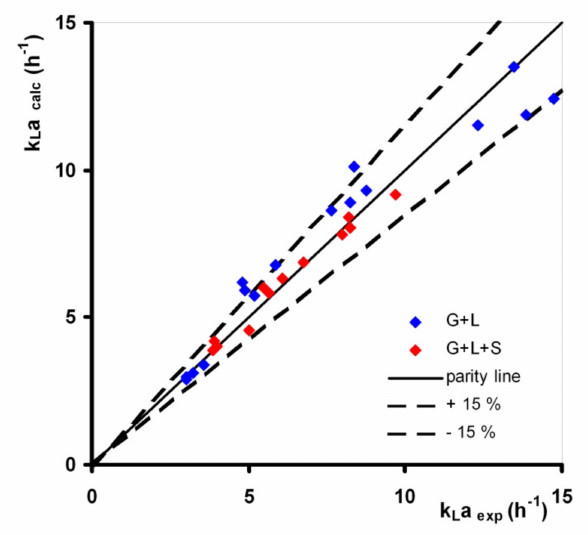
Figure 9. Overall volumetric mass transfer coefficient k L a : Comparison of experimental and calculated data using (12)–parity plot.